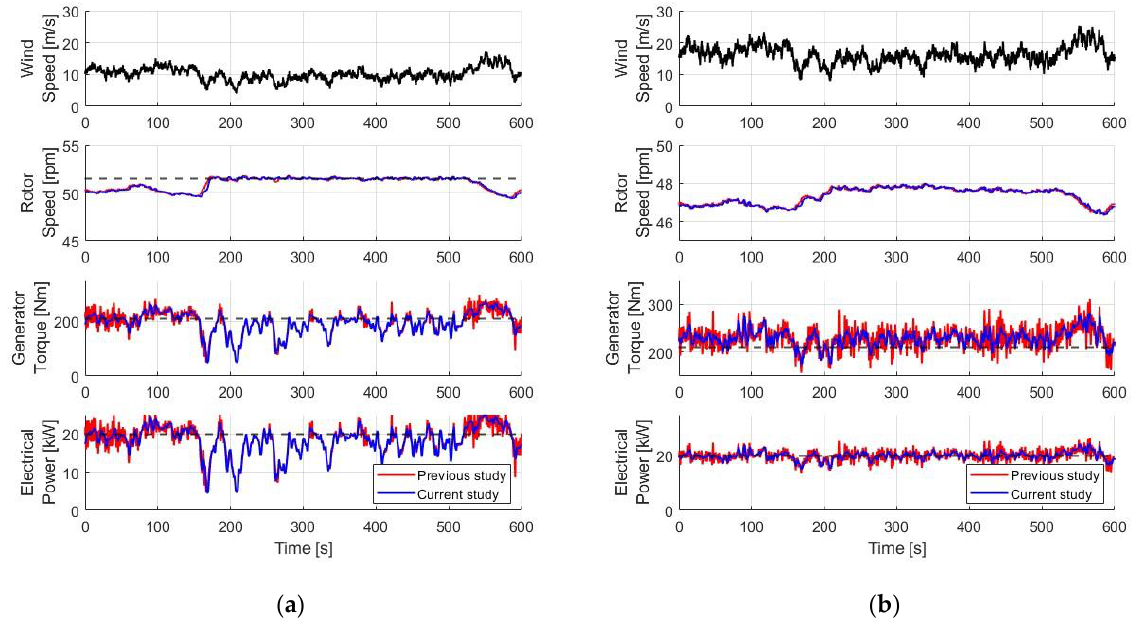
Figure 14. Dynamic simulation results of proposed stall control (current study) and stall control in a prior study (previous study): ( a ) average wind speed of 10 m/s (mostly Regions II and II-1/2); ( b ) average wind speed of 16 m/s (mostly Region III). Table 6. Quantitative comparison of controller performance at an average wind speed of 10 m/s with a turbulence intensity of 21% (mostly Regions II and II-1/2).